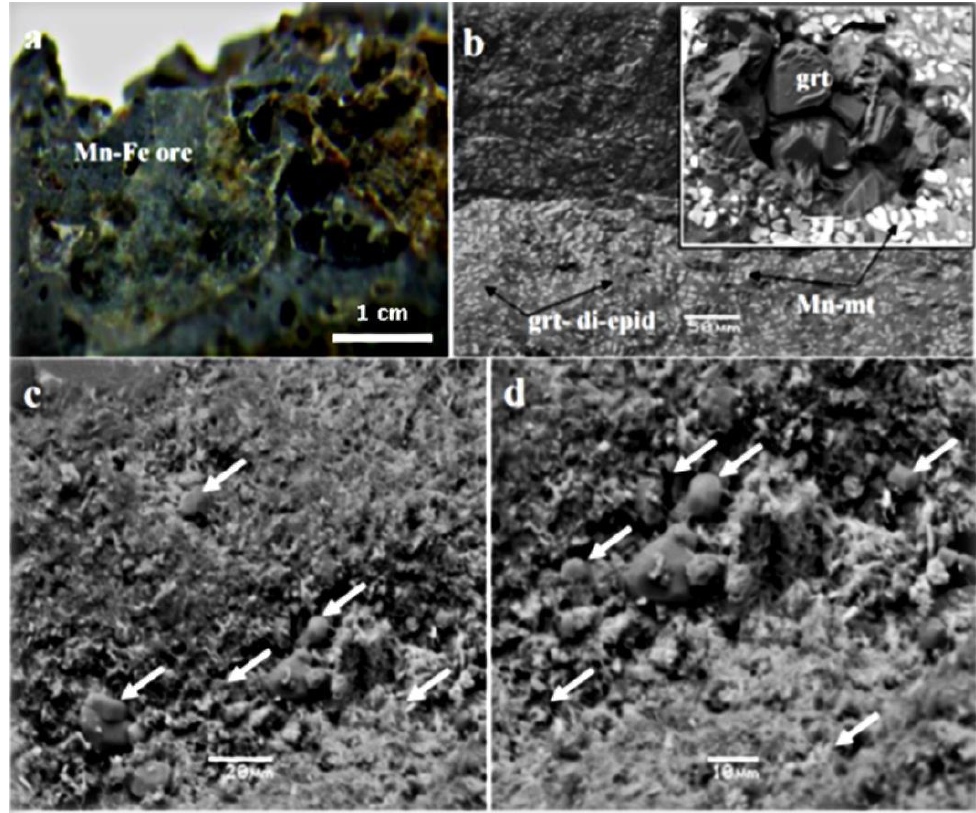
Figure 6. ( a ): Photograph of massive hydrothermal Mn-Fe ore from the area of Varnavas. ( b – d ): Back scattered images showing the dominant minerals, Mn-magnetite (Mn-mt) within a matrix con- sisting mostly of fine-grained Mn-bearing garnet (grt), diopside (di), and epidote (epid) (5b): The presence of fossilized bacterio-morphic Mn-Fe oxides/hydroxides (5c – d; white arrows) coated by a Na and Cl composed film, resembling NaCl (Table 1) is remarkable.